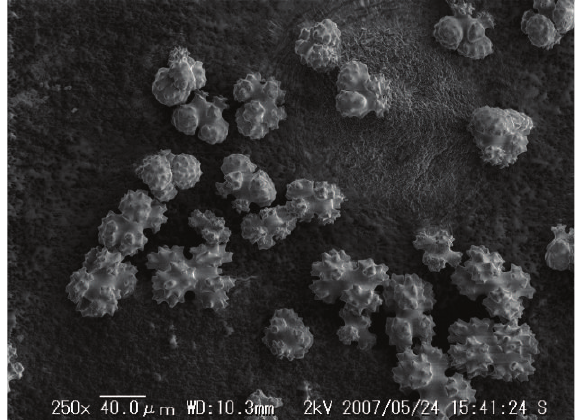
Figure 25: SEM image of sclerites of Corallium konojoi ; OCA- Cn20050619-020.